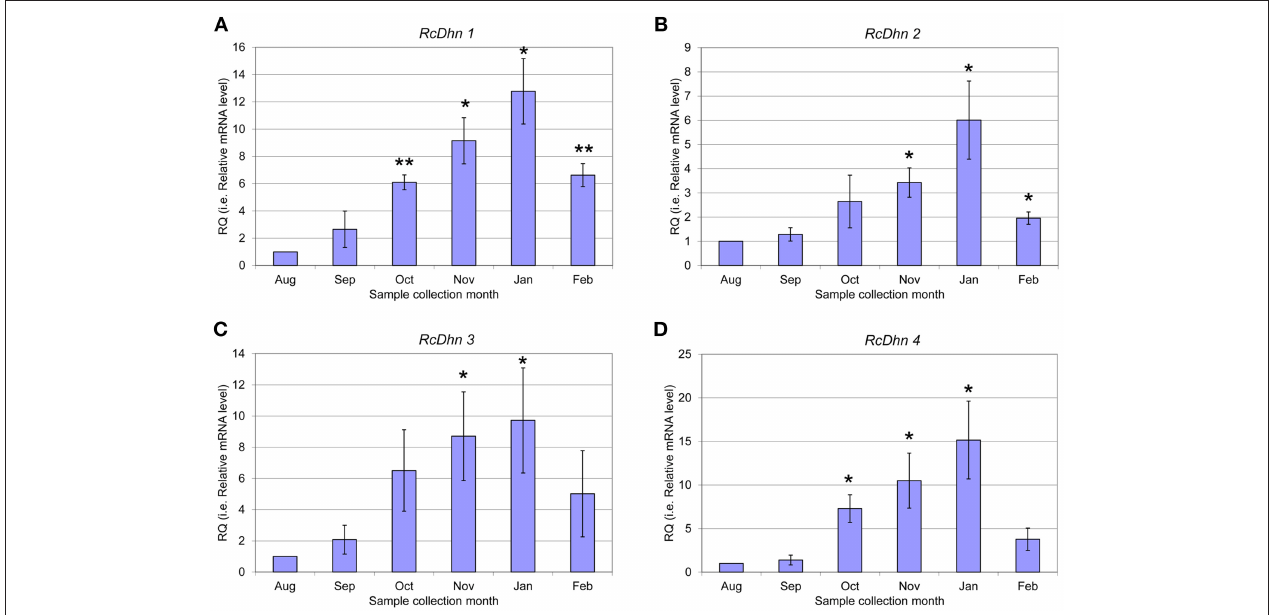
FIGURE 6 | Real-time RT-PCR analysis for monthly expression patterns of dehydrin genes in leaf tissues of field-grown R. catawbiense collected in August, September, October, November, January, and February (A-D) RcDhn 1-4 . Total RNA extracted from leaf tissues were used for cDNA synthesis. Real-time RT-PCR was conducted by using each dehydrin’s primers, while the gene-specific primers of rhododendron ubiquitin-like ( RcUbql ) gene for the reference gene. The monthly expression of each dehydrin gene was presented as the expression levels relative to its expression level in August (which was set at 1). * and ** indicate statistical significance of p < 0.05 and p < 0.01, respectively, comparing with the expression level in